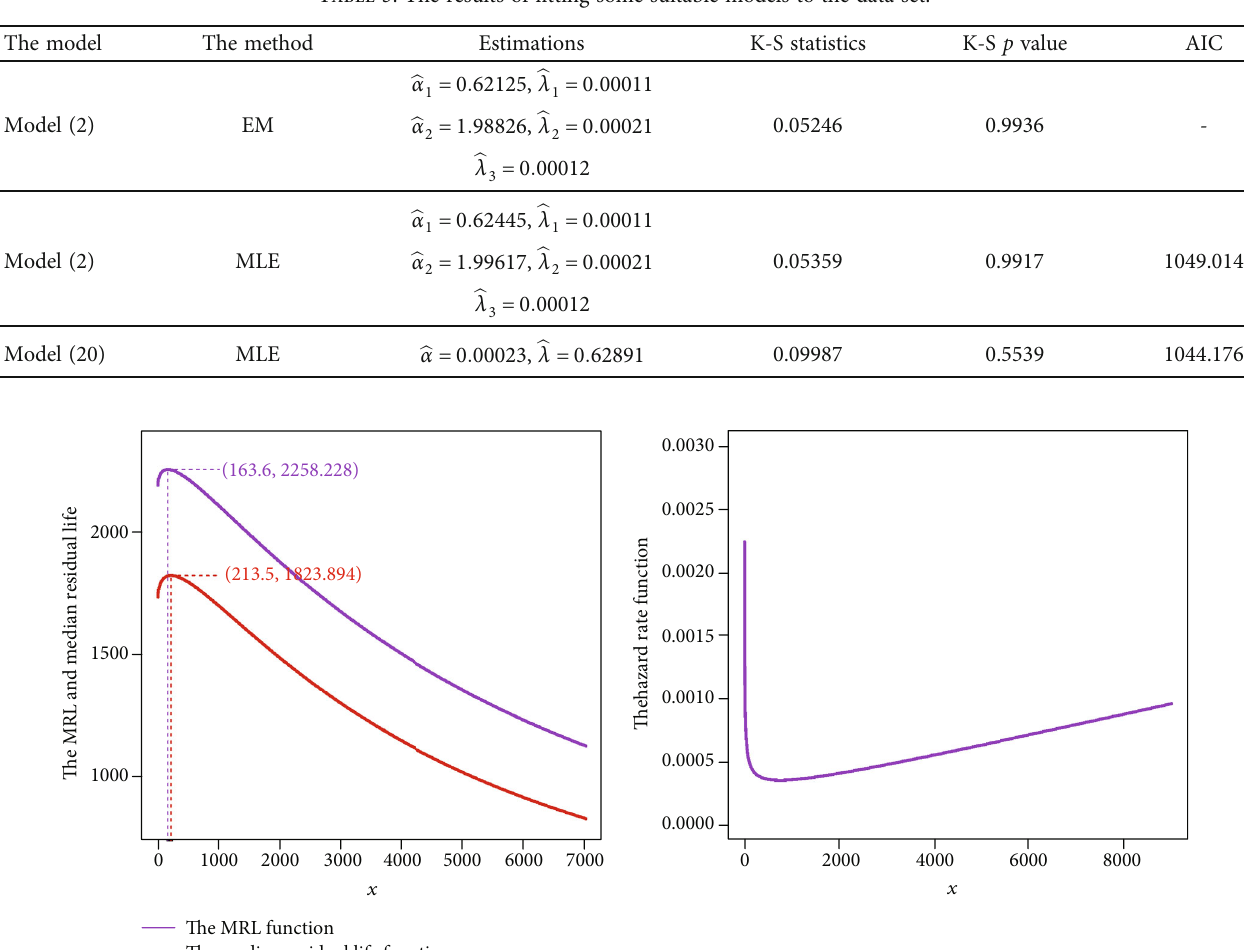
Table 3: The results of fi tting some suitable models to the data set.